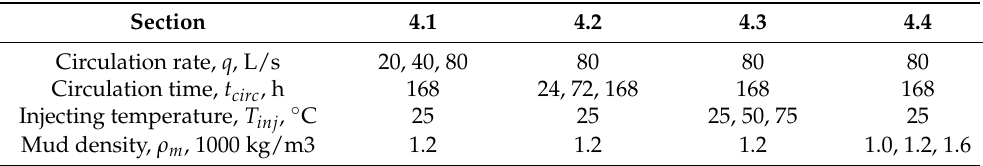
Table 2. Operational parameters for sensitivity analysis at each